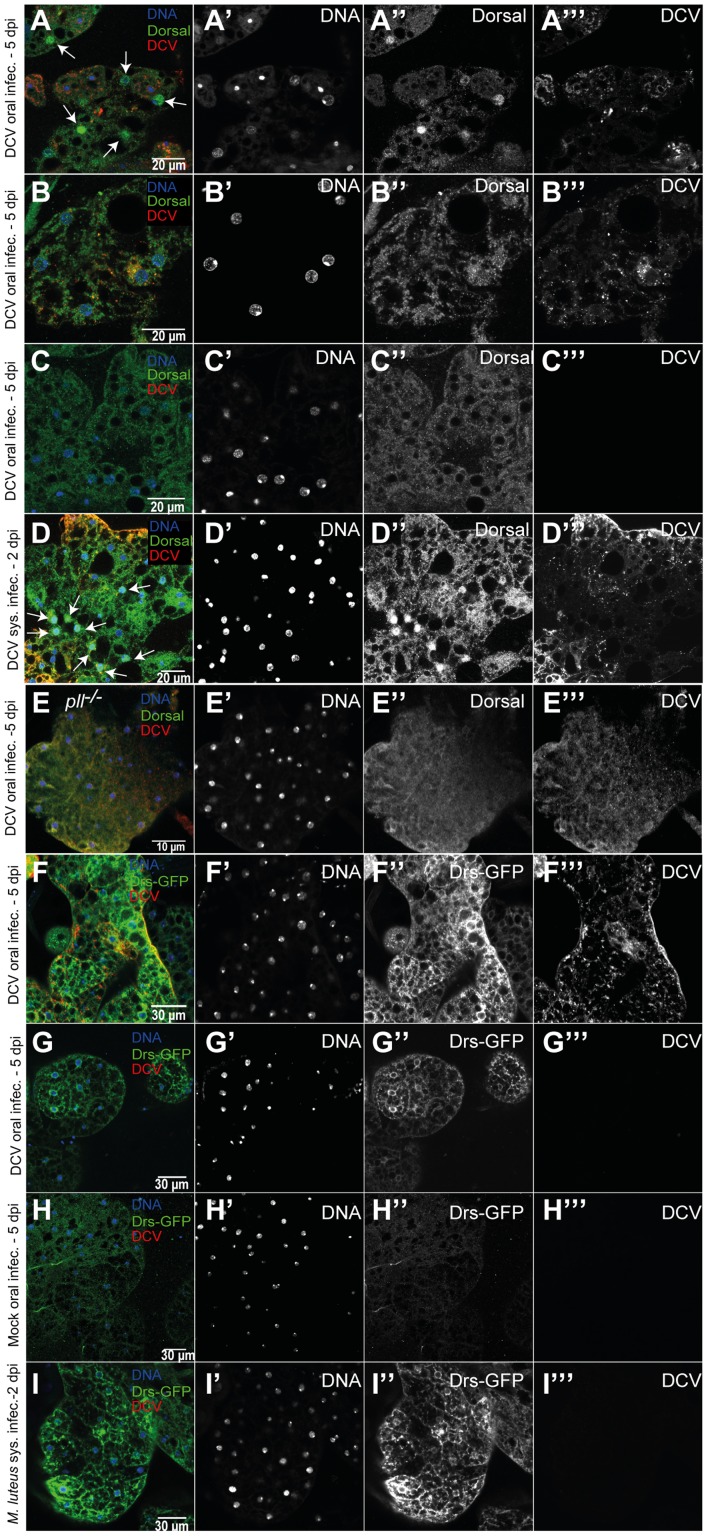
Toll pathway activation by DCV infection.(A–C) Dorsal localization in fat body cells 5 days after DCV oral infection (1011 TCID50/ml) of w1118 iso flies. All three fat body regions shown were dissected from the same fly and are representative of 14 DCV-positive flies (out of 20 total flies analysed). (A) DCV infected fat body region with nuclear import of Dorsal (white arrows). Nuclear import of Dorsal was observed in 4 out of the 14 DCV positive flies (B) DCV infected fat body region without nuclear import of Dorsal. (C) Fat body region not DCV infected without nuclear import of Dorsal. (D) Dorsal localization in fat body cells 2 days after DCV systemic infection (107 TCID50/ml) of w1118 iso flies, showing nuclear import of Dorsal (white arrows). Nuclear import of Dorsal was observed in 5 of 10 DCV positive flies. (E) Dorsal localization in fat body cells of pll−/− flies after DCV oral infection (Dorsal nuclear import was seen in 0 out of 16 DCV positive flies) (A–E) Adult male fat body was immunostained with an antibody against Dorsal (green), an antibody against DCV (red), and DNA was marked with DAPI (blue). (F–G) Drs-GFP expression in fat body 5 days after DCV oral infection. Both fat body regions shown were dissected from the same fly. (H) Drs-GFP expression in fat body after 5 days mock oral infection. (I) Drs-GFP in fat body after 2 days Micrococcus luteus oral infection. (F–I) Adult male fat body regions were immunostained with antibody against DCV (red), antibody against GFP (green), and DNA marked with TOTO3 (blue). DCV infections were performed in 3–6 days old flies.